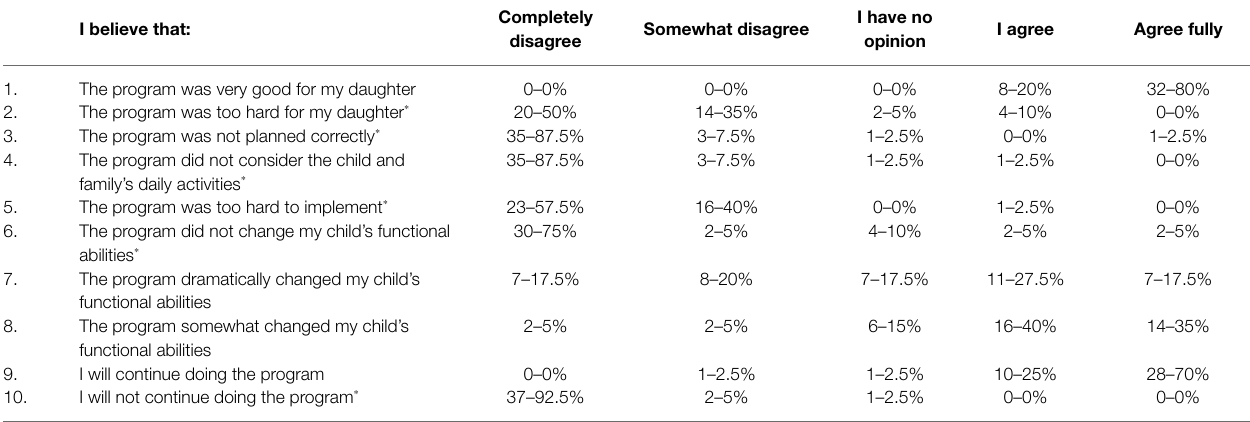
TABLE 2 | Sentences contained in the post-intervention questionnaire with number and percentage of parents’ answers for each score for each